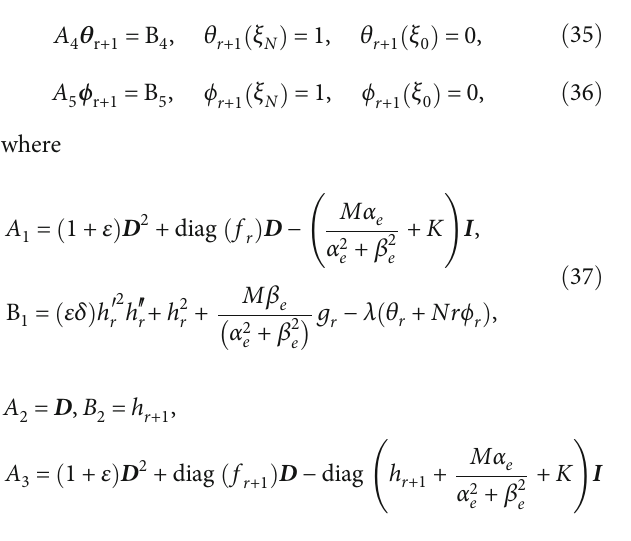
on the primary velocity f ′ ð η Þ . i